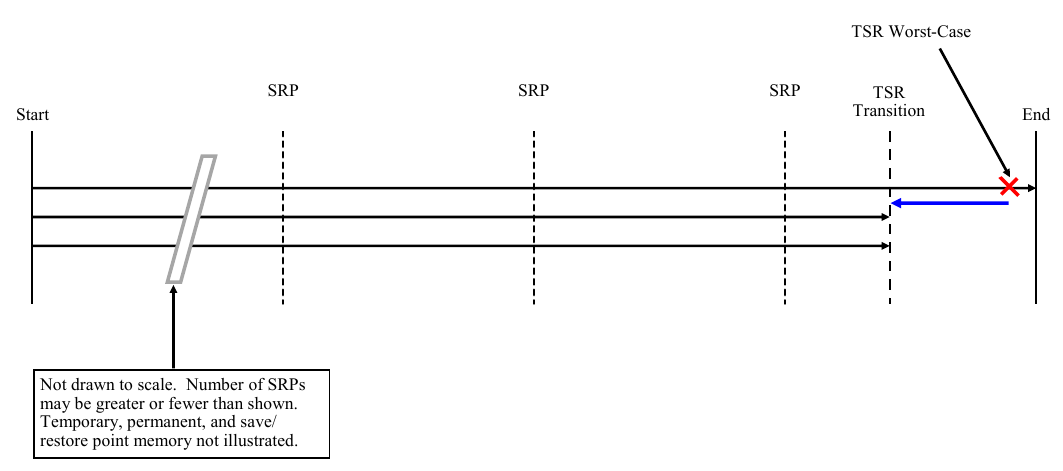
Figure A20. AHR MIPS TSR Worst-Case Early Error Timing Diagram